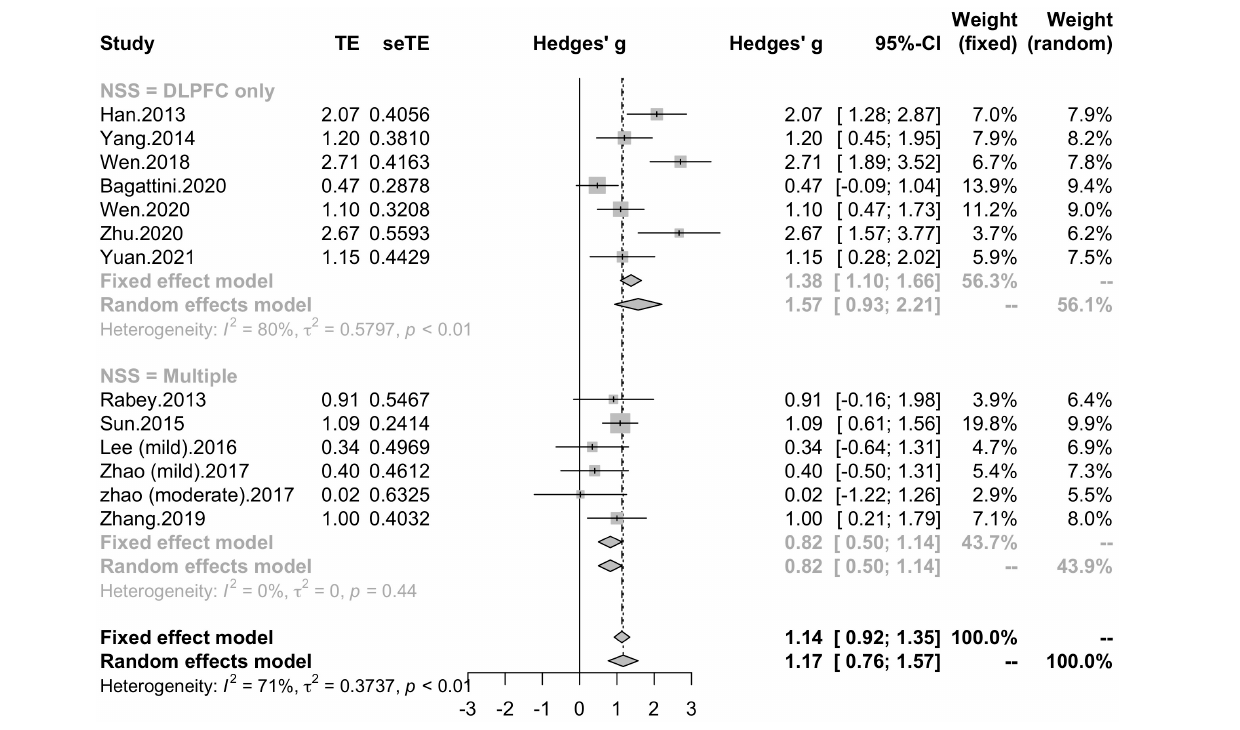
FIGURE 6 | Forest plot: mean differences in stimulation site pattern subgroups with 95% CI. NSS, number of session site.